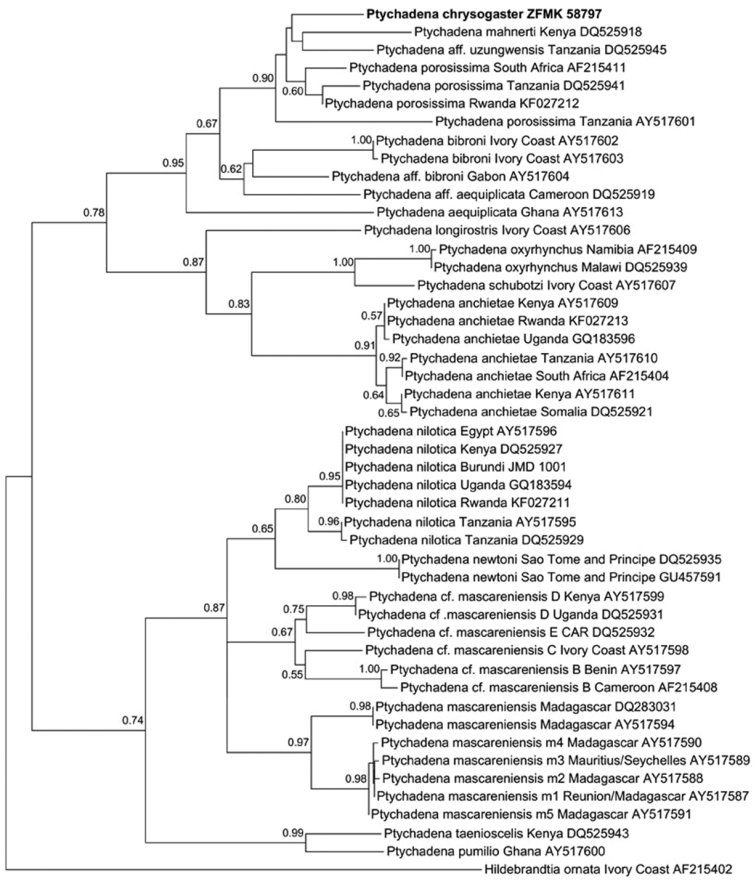
Maximum likelihood phylogram of species in the genus Ptychadena and Hildebrandtia ornata as outgroup, based on comparison of 548 base pairs of the mitochondrial 16S rRNA gene. Included are specimens from Rwanda and samples taken from GenBank (see Dehling and Sinsch in press for a complete list of sequences and accession numbers). Numbers above nodes are bootstrap support values (only values >0.50 are shown).